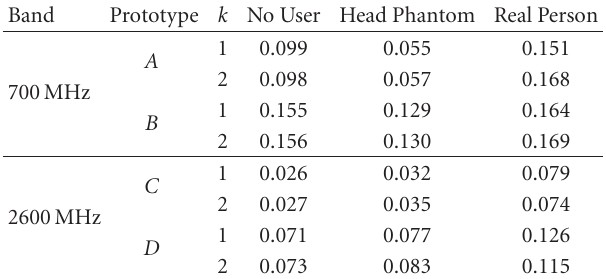
Table 2: Correlation results (standard deviation).